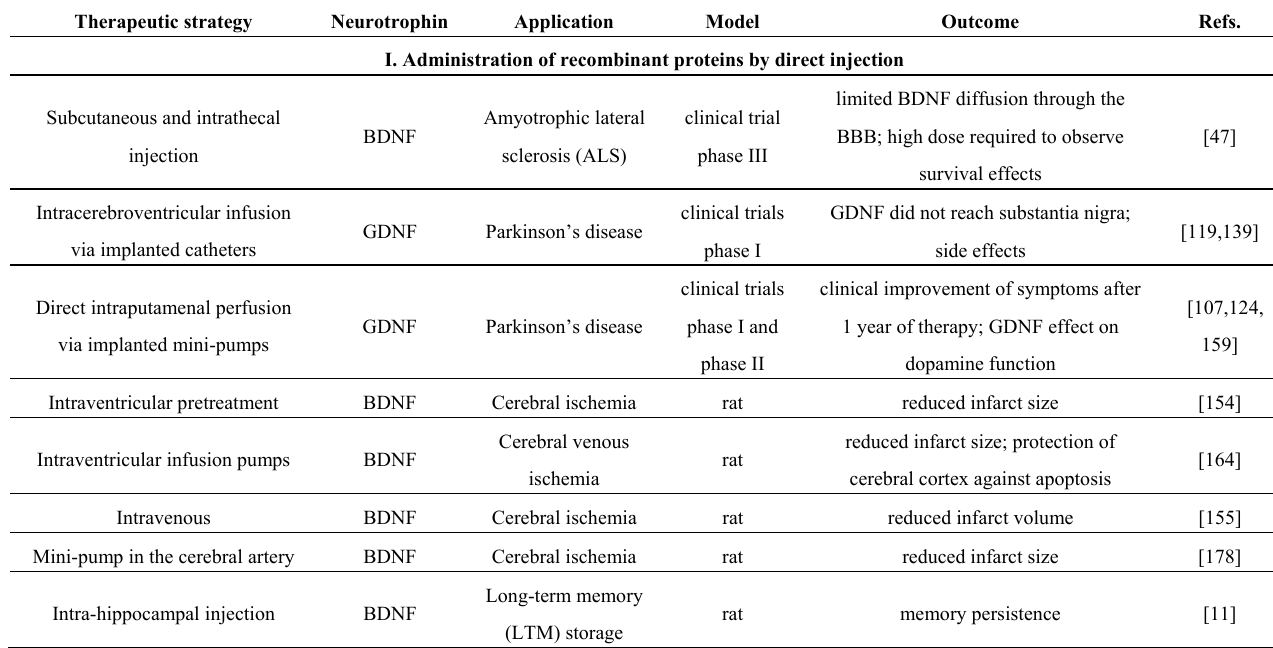
Table 1. Summary of therapeutic strategies for treatment with neurotrophins a